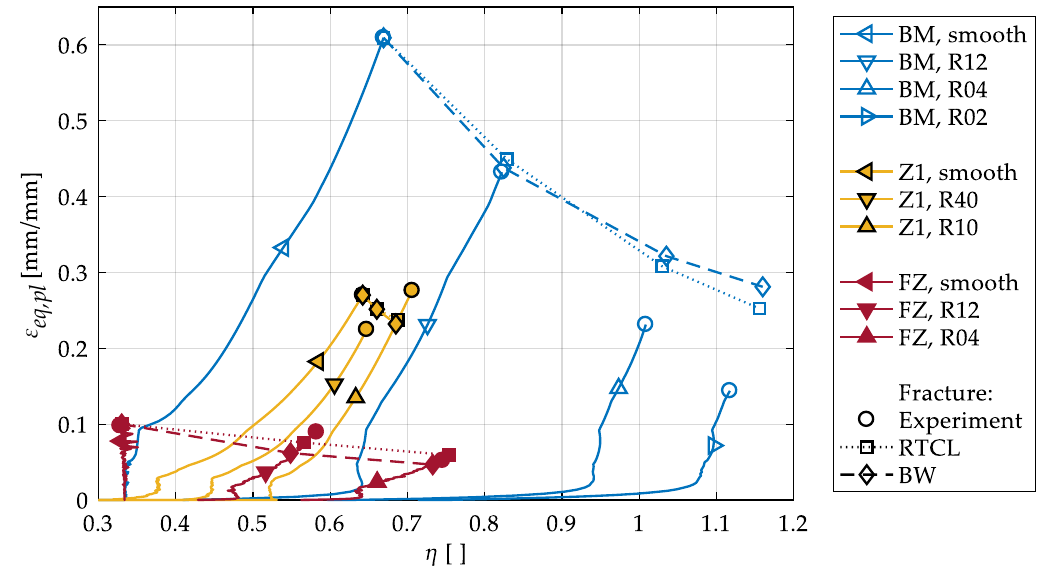
Figure 7. Calibration of ε f , ut of the Bao–Wierzbicki (BW) and Rice–Tracey / Cockcroft–Latham (RTCL) criteria with the evolution of ε eq , pl over η in smooth and notched tensile tests for BM, HAZ and FZ.